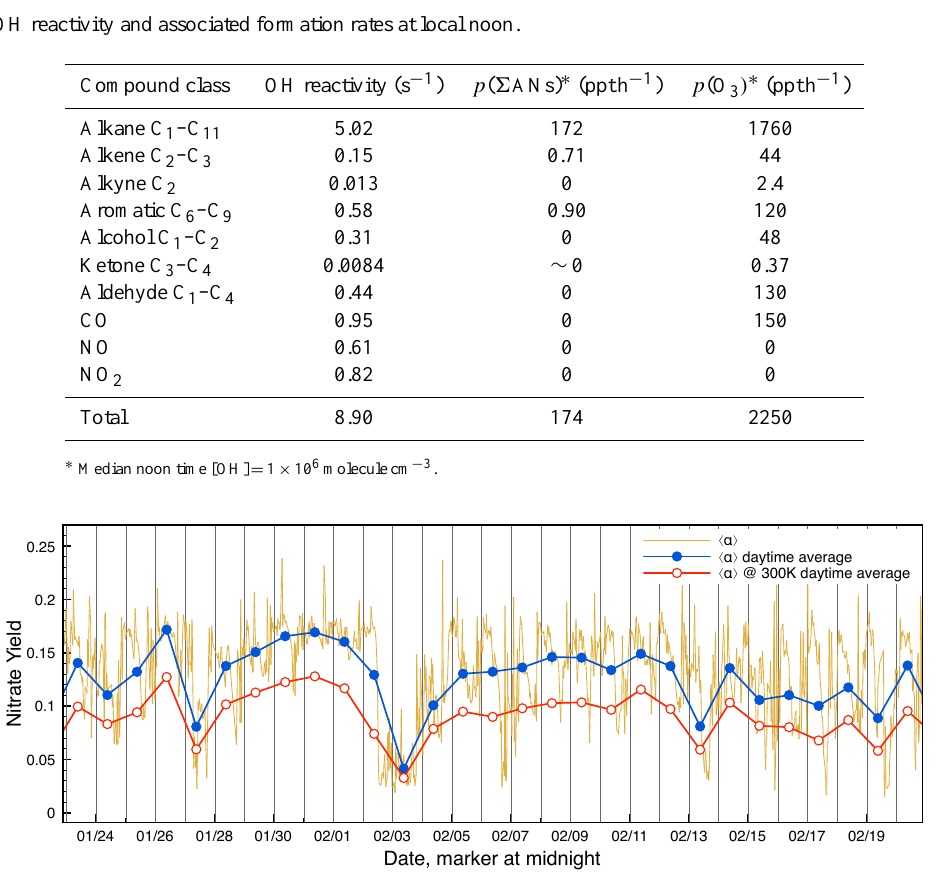
Figure 3. Ensemble-averaged nitrate formation yield ( (cid:104) α (cid:105) ) calculated based on the method in Sect. 3.2.1. Blue symbols represent daytime average of the hourly (cid:104) α (cid:105) (in orange) estimated at 273K, representative of the campaign period conditions. The red symbols are the daytime averaged (cid:104) α (cid:105) estimated at 300K, routinely used in global